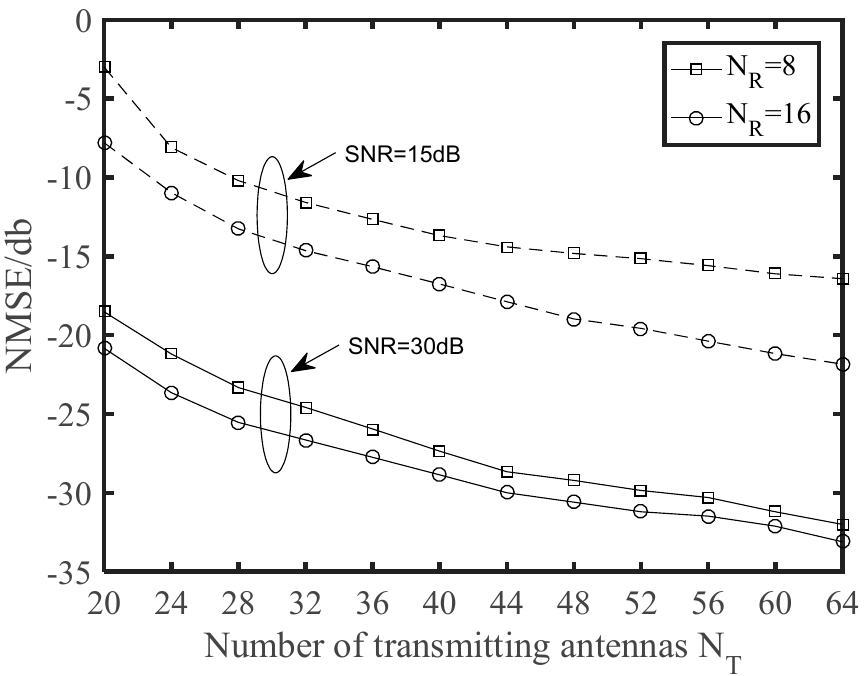
Figure 6. NMSE performance against the number of the transmitting antennas N T . The number of vehicles is 1, and its speed is v = 120 km/h.